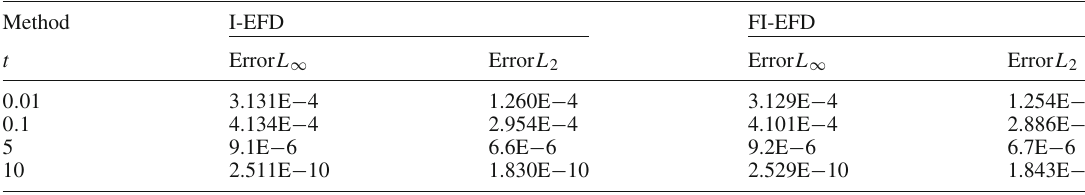
Table 2 L ∞ and L 2 errors of Example 5.1 for (cid:2) x = 0 . 05 and (cid:2) t = 10 − 3